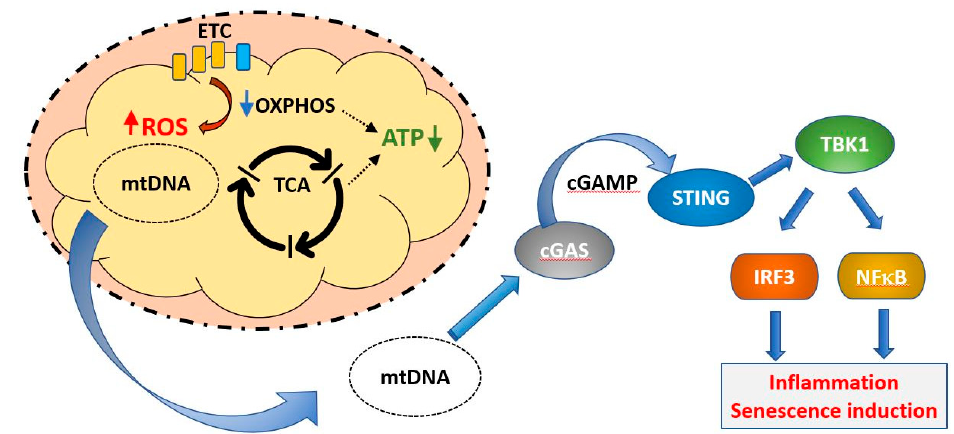
Figure 9. Induction of cellular senescence programs by mitochondrial DNA. Under normal healthy conditions, defective mitochondria (exhibiting decreased OXPHOS, blue arrow, decreased ATP production, green arrow, and increased ROS production, red arrow) are removed by mitophagy and mitochondrial DNA is not released into the cytoplasm. If this process is unable to deal with the increasing load of mitochondrial damage during ageing, mtDNA may be released to the cytoplasm, where it constitutes a damage associated molecular pattern (DAMP). mtDNA is recognized by the enzyme cGAMP, which synthesizes the intermediate cyclic guanosine monophosphate–adenosine monophosphate (cGAMP). This activates the transcription factor stimulator of interferon genes (STING), which upregulates transcriptional programs controlled by IRF3 and NF κ B, resulting in the induction of cellular senescence. Blue arrows indicate the pathway connecting dysfunctional mitochondria with senescence induction.